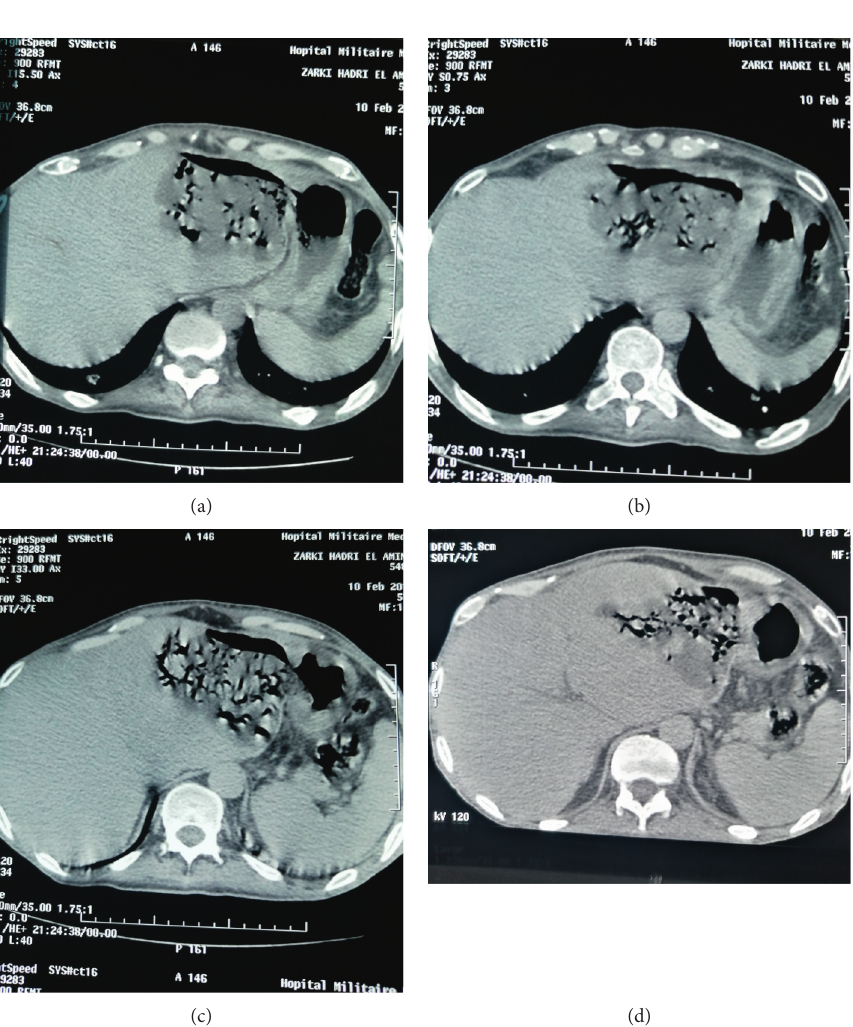
Figure 1: Preoperative CT scan showing (a, b) liver cystic mass containing multiple air foci; (c, d) hepatogastric fistula.